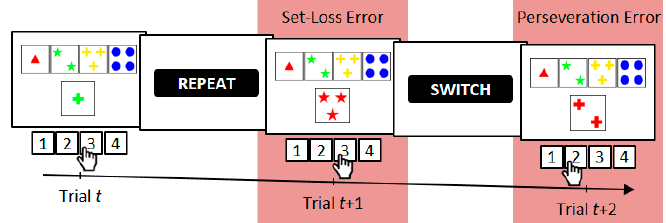
Figure 1. An exemplary trial sequence on the computerized Wisconsin Card Sorting Test (WCST) [27,45–48]. On Trial t , a stimulus card (one green cross) could be sorted by the color category (inner left key card, response 2), the number category (far left key card, response 1), or the shape category (inner right key card, response 3). In the current example, the shape category was applied as indicated by observing response 3. A positive feedback (i.e., the visually presented word “REPEAT”) indicated that this sort was correct, implying that the shape category should be repeated on the upcoming trials. However, on Trial t +1, the number category was applied, as indicated by observing response 3. Erroneous switches of the applied category after positive feedbacks are referred to as a set-loss errors. A subsequently presented negative feedback stimulus (i.e., the visually presented word “SWITCH”) announced that that sort was incorrect, implying that a category switch is required. On Trial t + 2 of the current example, the number category was repeated, as indicated by observing response 2. Erroneous repetitions of categories following negative feedbacks are referred to as perseveration